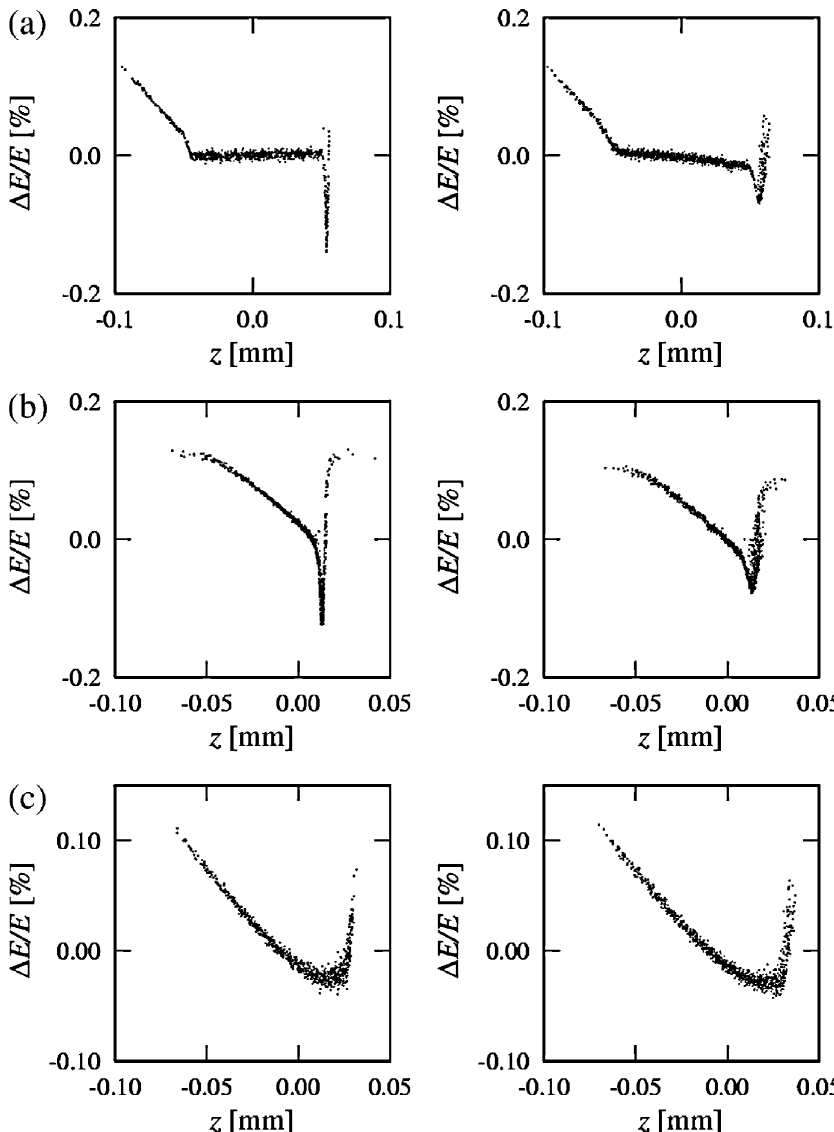
FIG. 5. Phase space at 1.7 GeV showing upright bunch tails for bunches with peak current of 50 A and Gaussian energy spread of 3 keV before compression. LITRACK (with resistive impedance) results are on the left; ELEGANT results with coherent radiation are on the right. (a) Trapezoidal bunch with 2-mm flattop, 480 - (cid:2) m head and tail. (b) Gaussian bunch with (cid:5) ¼ 430 (cid:2) m with (cid:5) z